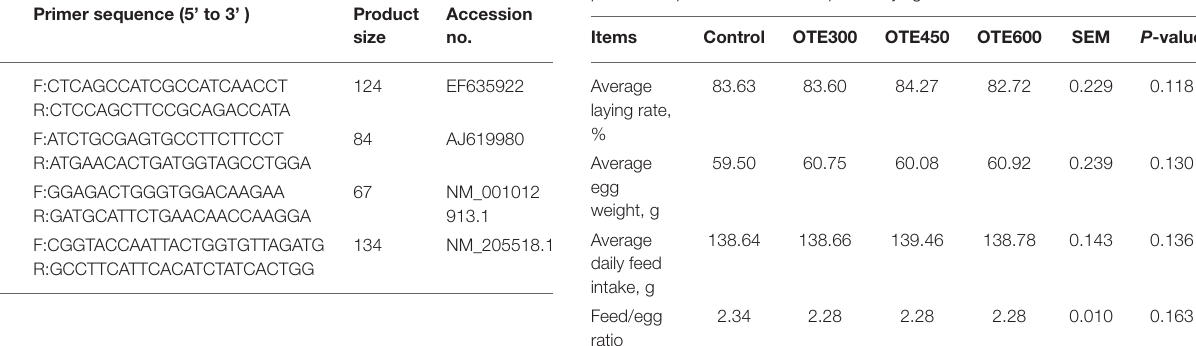
TABLE 4 | Effects of dietary organic trace elements supplementation on production performance of late-phase laying